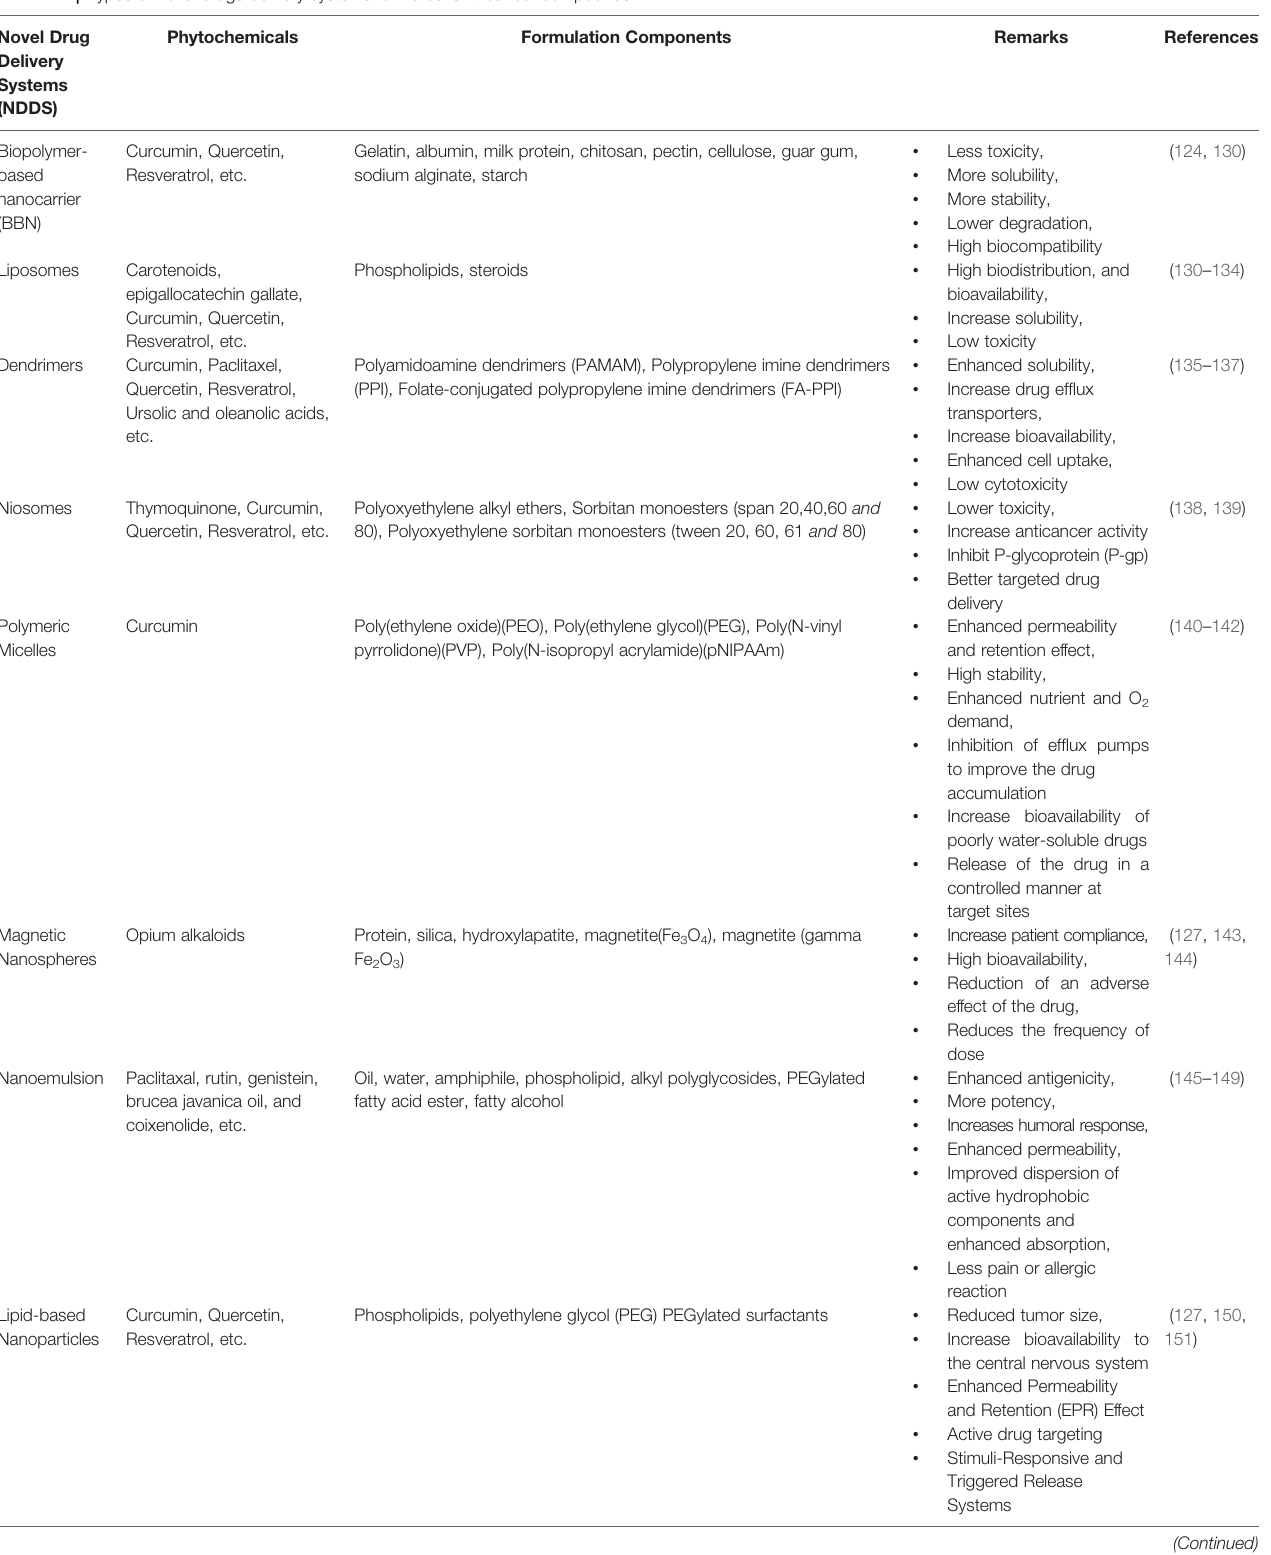
TABLE 2 | Types of novel drugs delivery systems for herbal anti-cancer compounds. Novel Drug